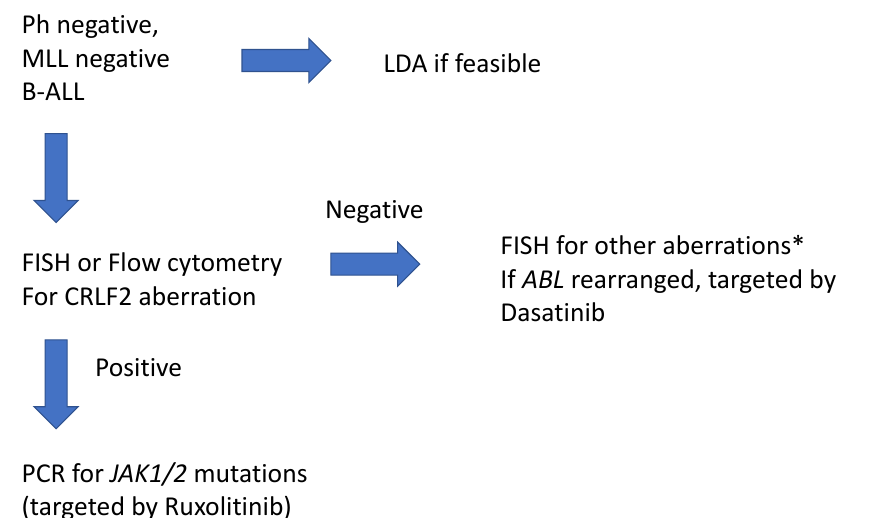
Figure 4. Proposed testing algorithm for Ph-like ALL in the clinical setting. MLL: Mixed Lineage Leukemia; FISH: fluorescent in situ hybridization; PCR: polymerase chain reaction; LDA: low density array. *Other aberrations include—ABL1, ABL2, CRLF2, JAK2, EPOR, PDGFRB, and CSF1R.